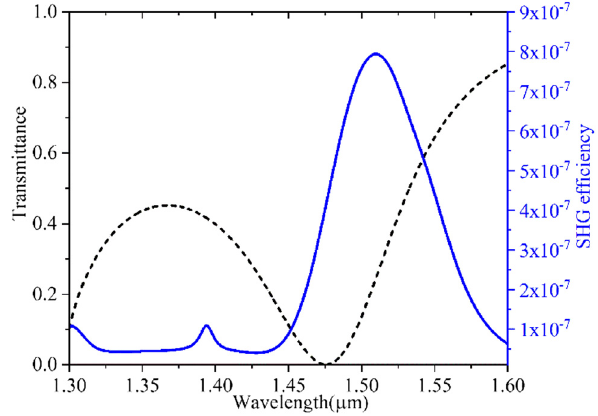
Figure 5: Transmission spectrum (dashed black line) and the second-harmonic generations (SHG) efficiency (blue line) from the magneticdipole(MD)resonancesupportedbythe AlGaAsdiskarray with no slot. Dimensions are similar to the slotted disk